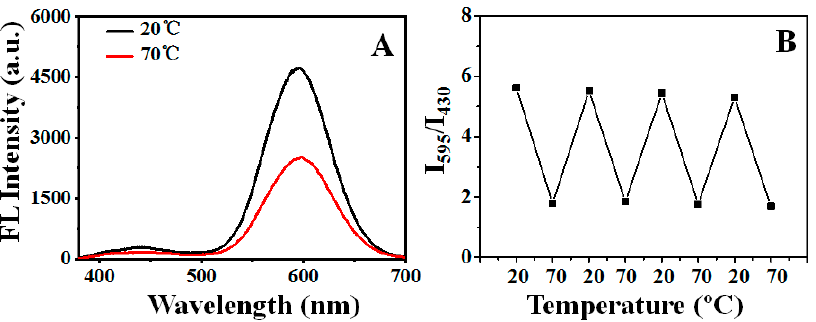
Figure 3. ( A ) Fluorescence emission spectra of DE-Au NCs under various temperatures. ( B ) Reversi- ble temperature dependence of the fluorescence intensity ratio (I 595 /I 430 ) of DE-Au NCs.